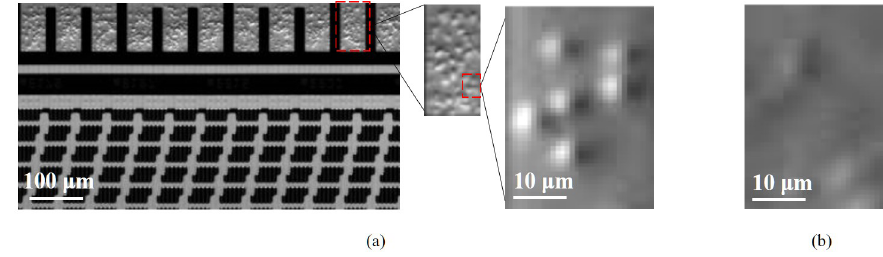
Figure 10. ( a ) Well deformed conductive particles; ( b ) over-deformed